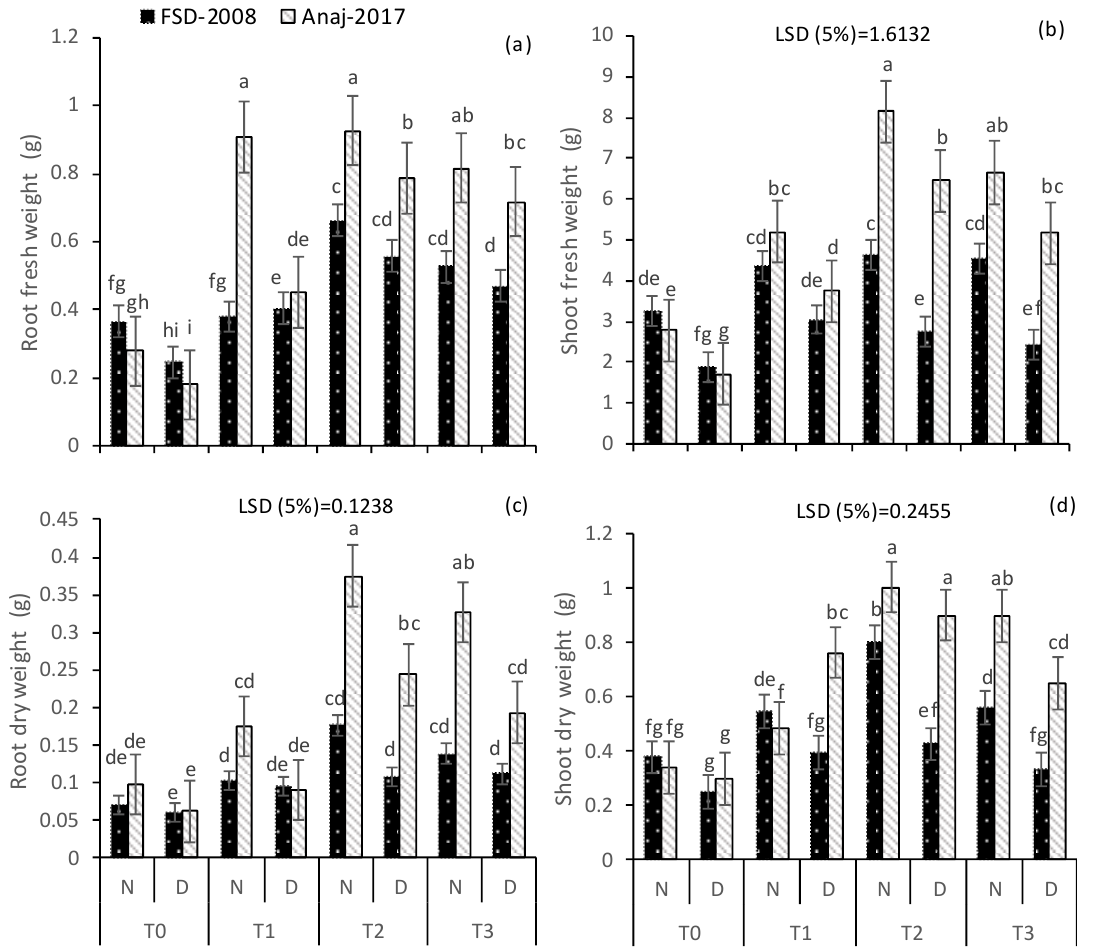
Figure 2. Effects of laser seed priming on ( a ) root fresh weight, ( b ) shoot fresh weight, ( c ) root dry weight and ( d ) shoot dry weight in wheat under drought stress. Legend: N = Control (100% field capacity), D = Drought (50% field capacity), T0 = Unprimed control, T1 = 1 min laser priming, T2 = 2 min laser priming and T3 = 5 min laser priming. Means sharing same lowercase letters on bars are statistically non−significant at P ≤ 0.05%)